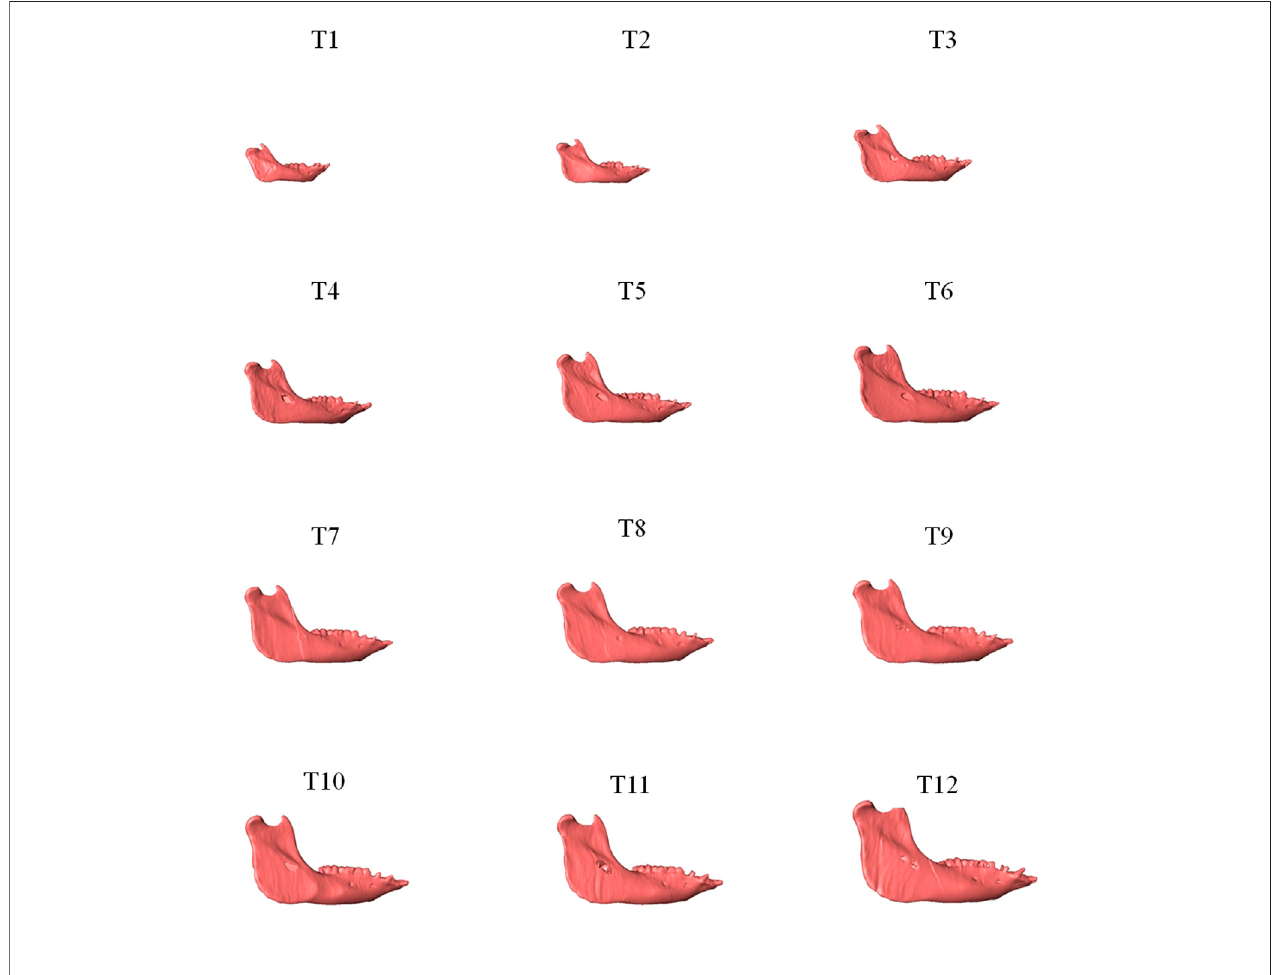
FIGURE 2 | Lateral view of the mandibles of a typical subject showing monthly size and shape changes over the growing period from T1 to T12.